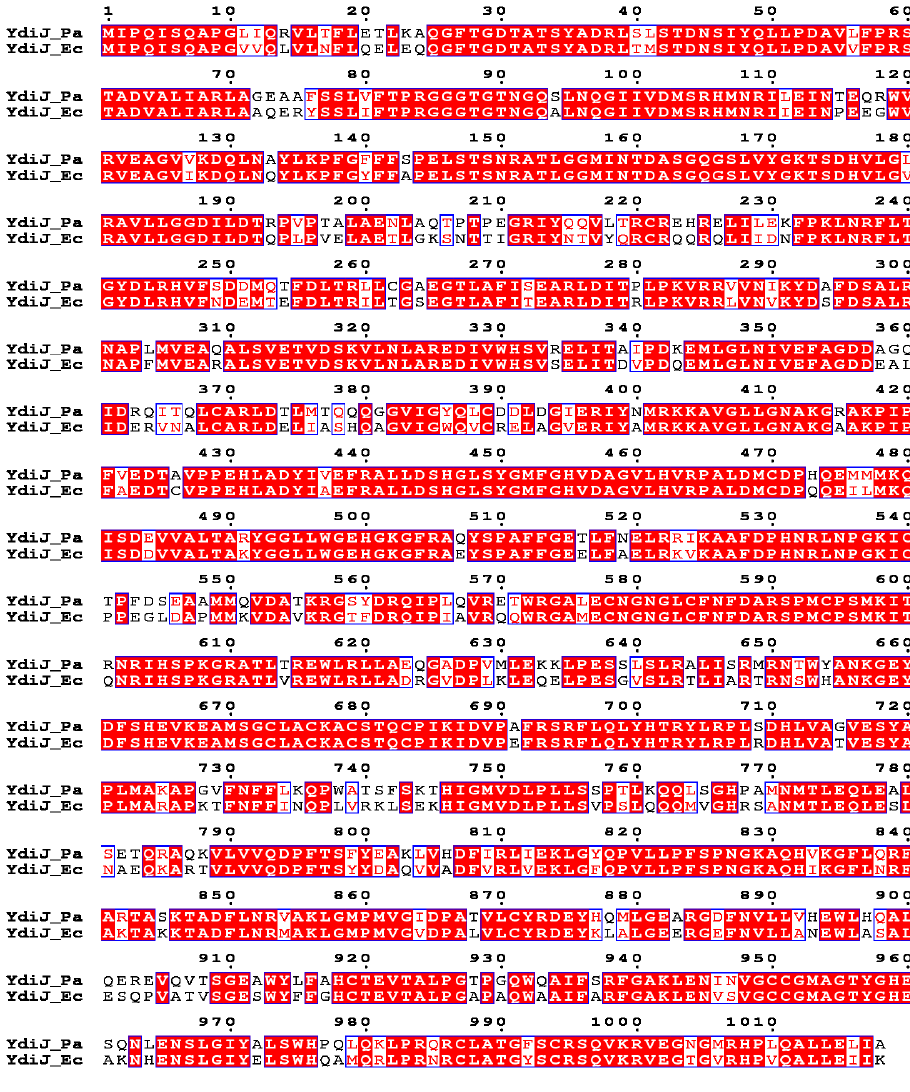
Figure 2. Sequence alignment of the YdiJs (D2HGDHs) of P. ananatis ( Pa ) and E. coli ( Ec ). The conserved amino acids are highlighted in shaded red boxes; conserved replacements are highlighted as red letters in blue boxes. The alignment was drawn with ESPRIPT 3.0.